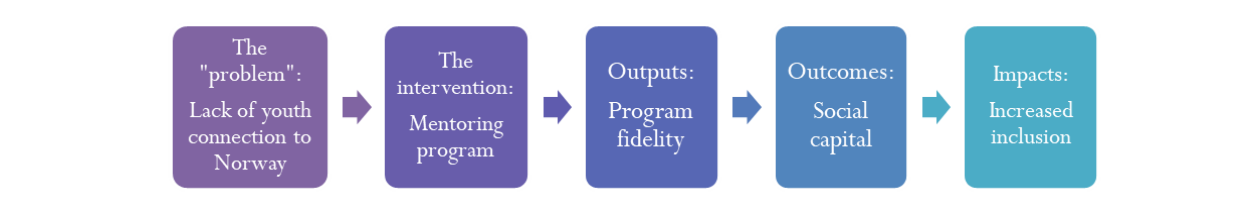
Figure 1. Logic model for the protocol (based on